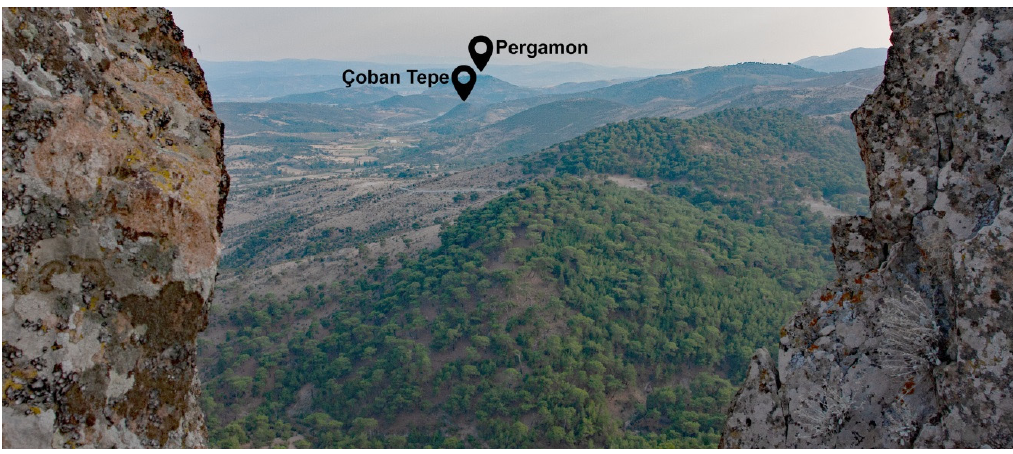
Figure 28. View from the site near Avunduruk to the south.